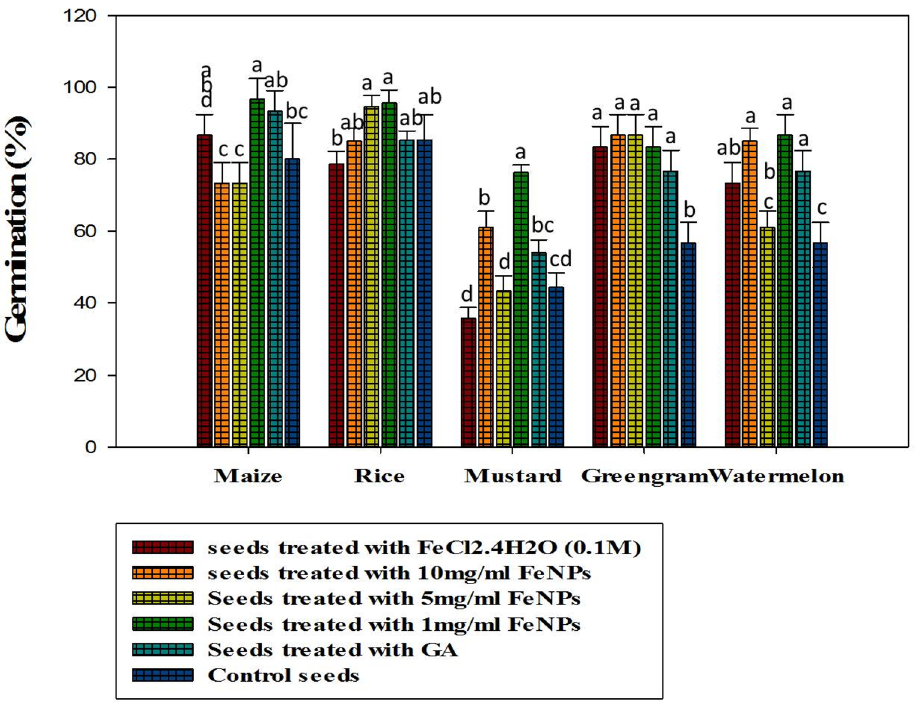
Figure 4. Percentage of seed germination in vitro condition with different doses of Fe 3 O 4 -NPs synthesized by pH-12. Data are mean ± SD. Each group without sharing letter mean statistical significance ( P ≤ 0.05).